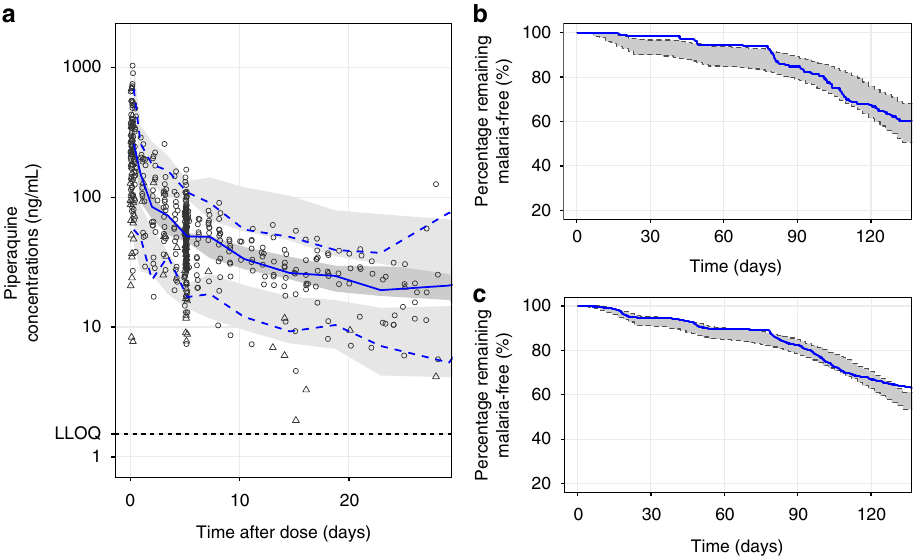
Fig. 1 Visual predictive checks of the fi nal population pharmacokinetic and pharmacodynamic model of piperaquine. a The fi nal population pharmacokinetic model, b the interval-censoring time-to-event model of the internal data, and c the fi nal pharmacodynamic model predicting the external data. Open circles represent observed capillary plasma piperaquine concentrations and open triangles represent observed venous plasma concentrations. A solid line represents the median observed plasma concentrations and dashed lines represent the 5 th and 95 th percentiles of the observed plasma concentrations. Shaded areas represent the predicted 95% con fi dence intervals of each percentile. Solid lines in panel ( b ) and ( c ) represent observed Kaplan – Meier survival plots. Shaded areas represent the 95% prediction